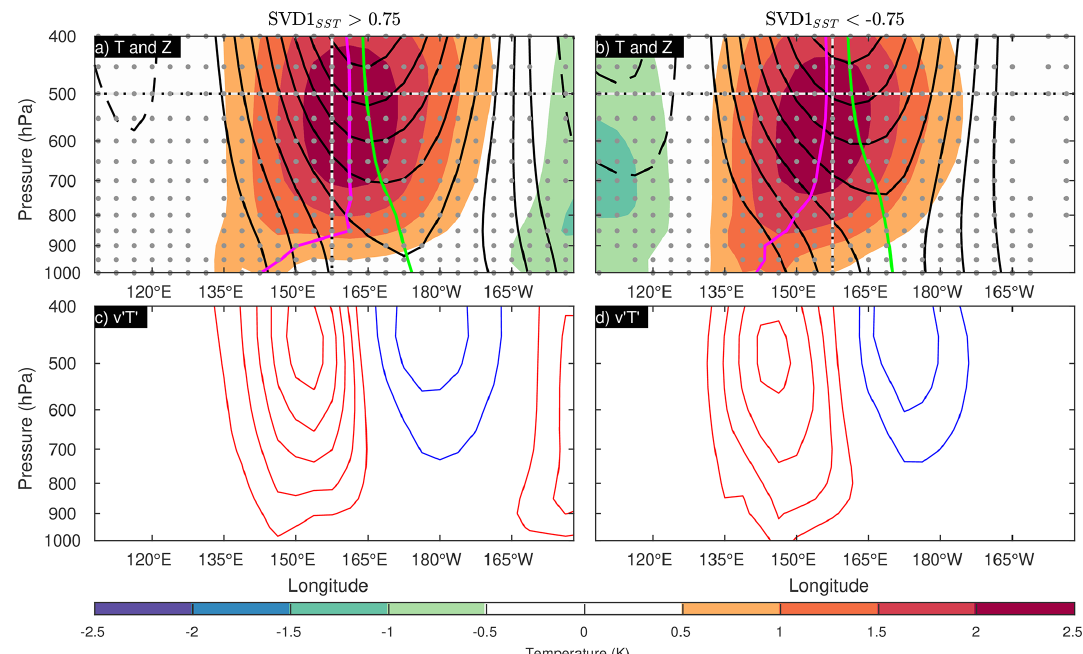
Figure 8. (a, b) Zonal sections of subseasonal anomalies in geopotential height (black contours with intervals of 10m; solid and dashed lines are used for positive and negative values, respectively) and temperature (shadings) both regressed onto the reference time series of 500hPa geopotential height at [45 ◦ N, 157.5 ◦ E] (green circles on Figs. 3c and 6), for winters when ( a ; left) SVD1 SST > 0 . 75 and ( b , right) SVD1 SST < − 0 . 75. The maxima of the height and temperature anomalies at individual pressure levels are connected vertically with green and magenta lines, respectively. (c, d) The associated meridional heat fluxes ( v (cid:48) T (cid:48) ) are contoured at intervals of 1mKs − 1 with red and blue lines for positive (northward) and negative (southward) values, respectively. Stippling indicates geopotential height values that are statistically significant at the α FDR = 0 . 1 significance level.